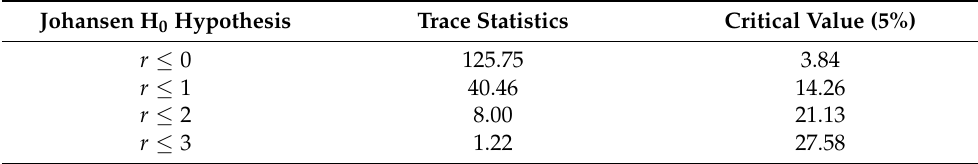
Table 3. The Johansen trace test results.